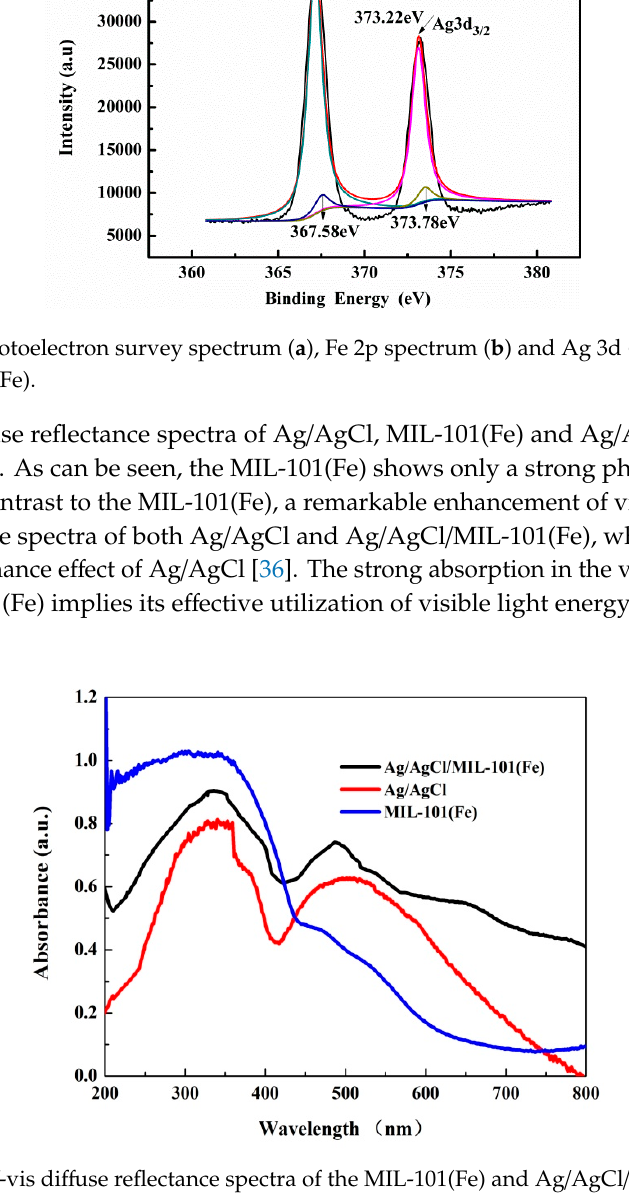
Figure 6. X ‐ ray photoelectron survey spectrum ( a ), Fe 2p spectrum ( b ) and Ag 3d ( c ) spectrum of the Ag/AgCl/MIL ‐ 101(Fe).